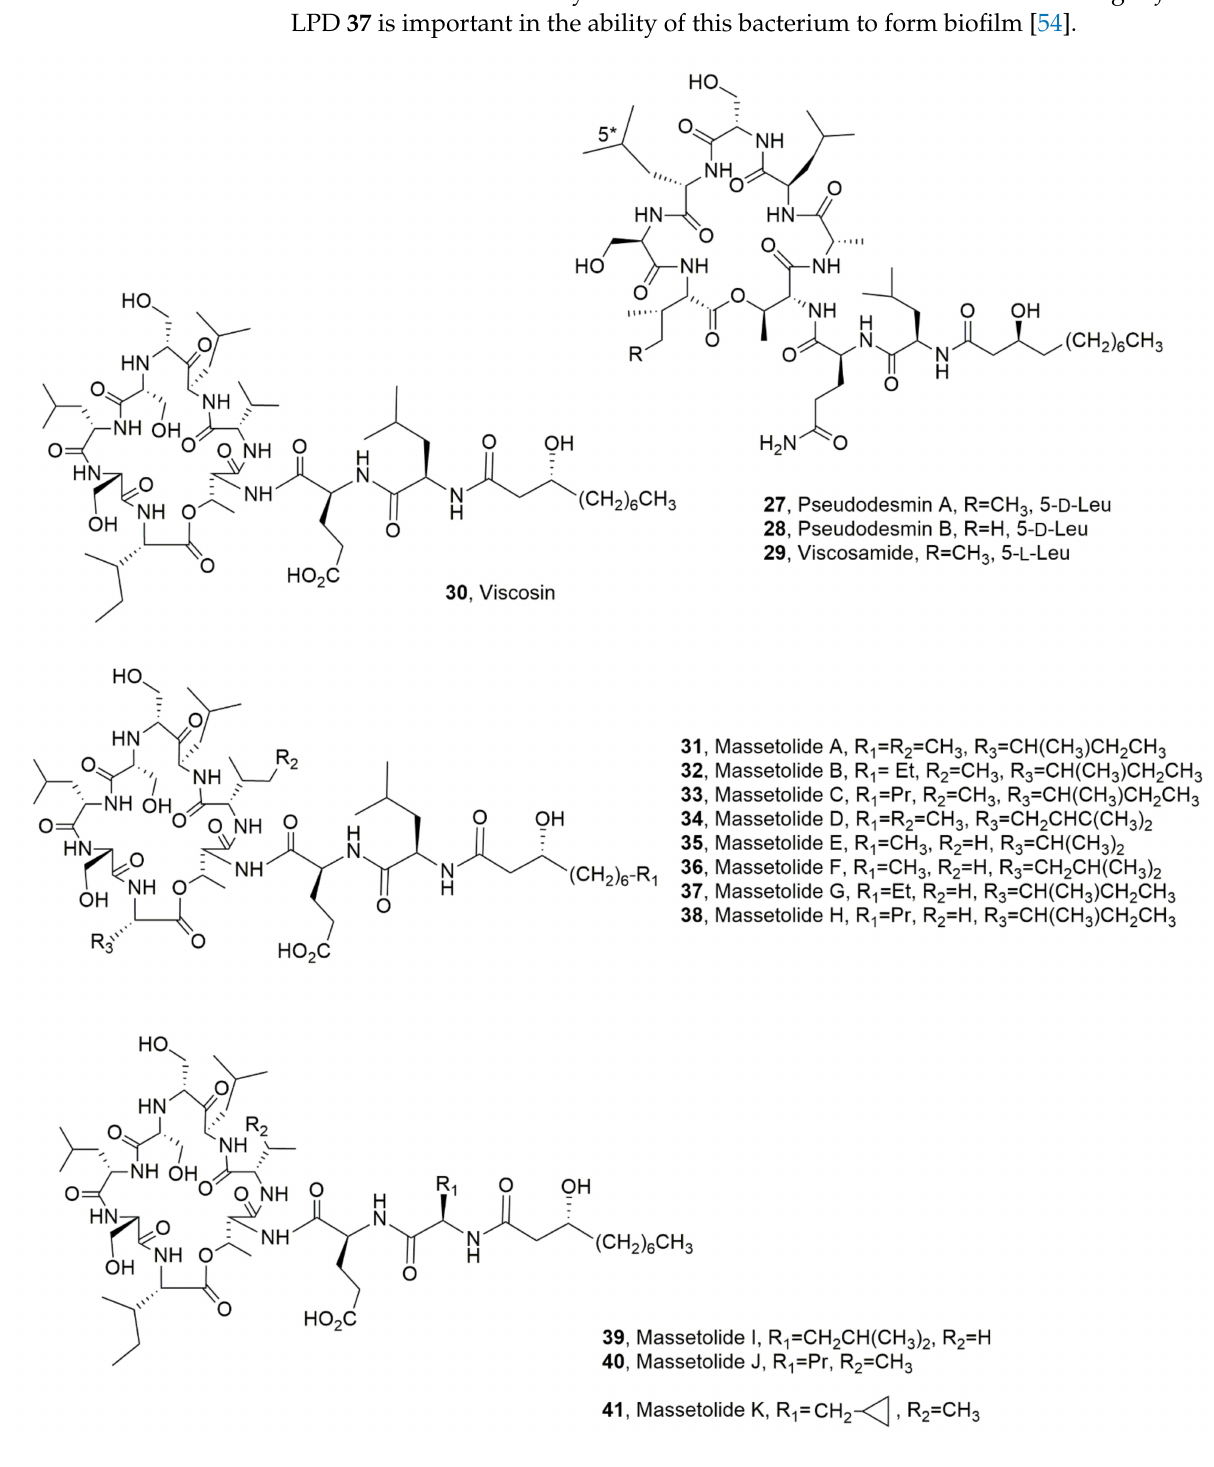
Figure 6. Structures of lipodepsipedtide produced by Pseudomonas tolaasii ( 27 and 28 ), Pseudomonas fluorescens and Pseudomonas libanensis ( 30 ), and P. fluorescens ( 29 – 41